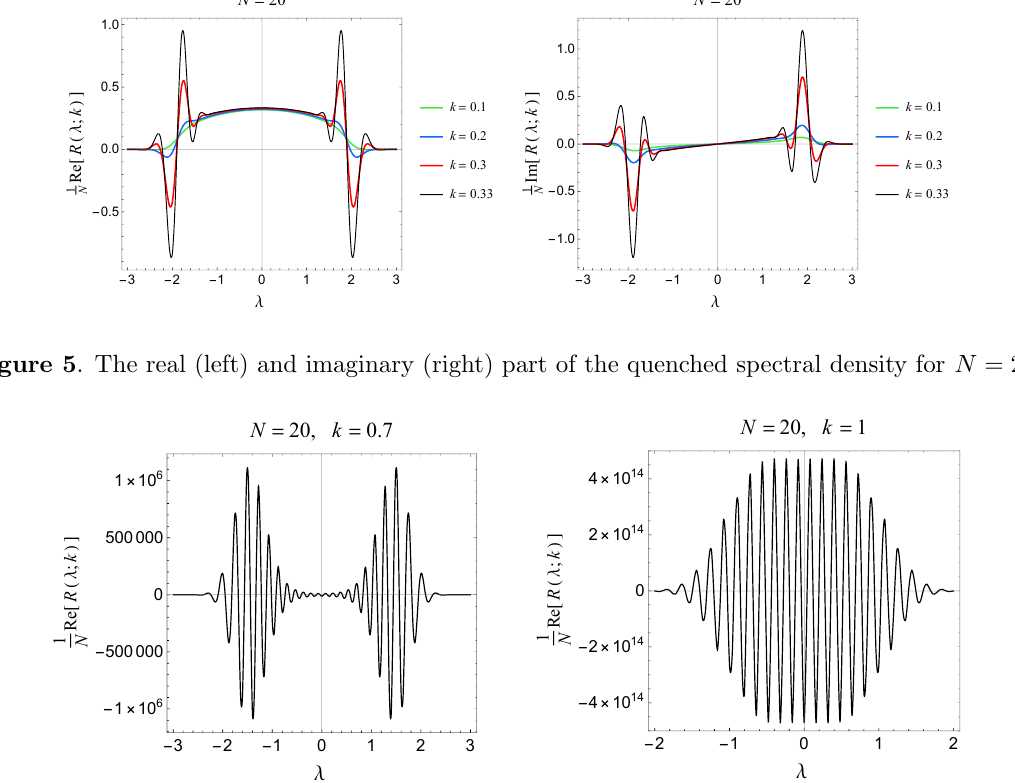
density does not remain strictly positive. The amplitudes of the oscillations grow rapidly R with k , even though the normalization condition d (cid:21) R ( (cid:21) ; k ) = N is strictly satis(cid:12)ed. A similar oscillation of the spectral density was also observed in matrix models for QCD